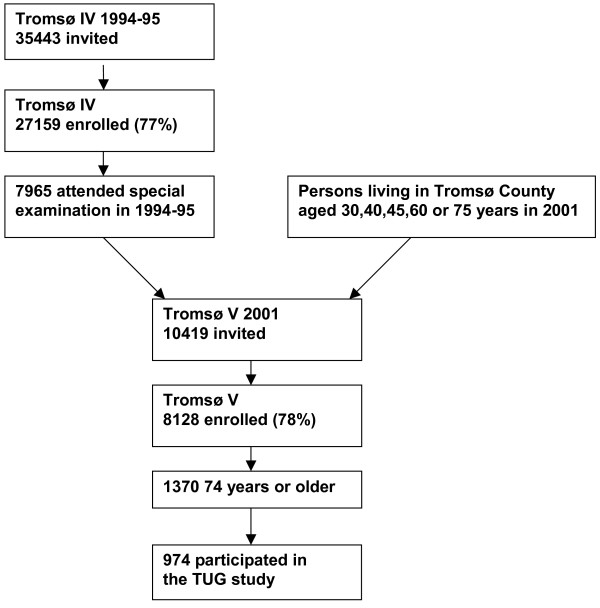
Study population.